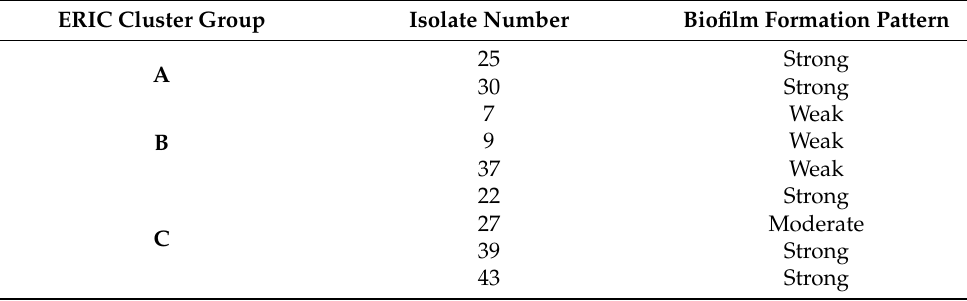
Table 1. Biofilm formation phenotypes of Acinetobacter baumannii isolates genotypically characterized by